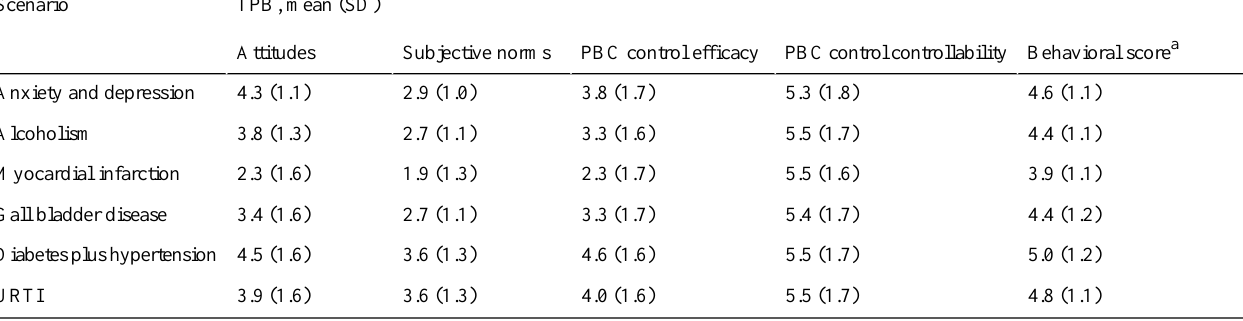
Table 6. Participants’response as per the domains of TPB per scenario (N=46).